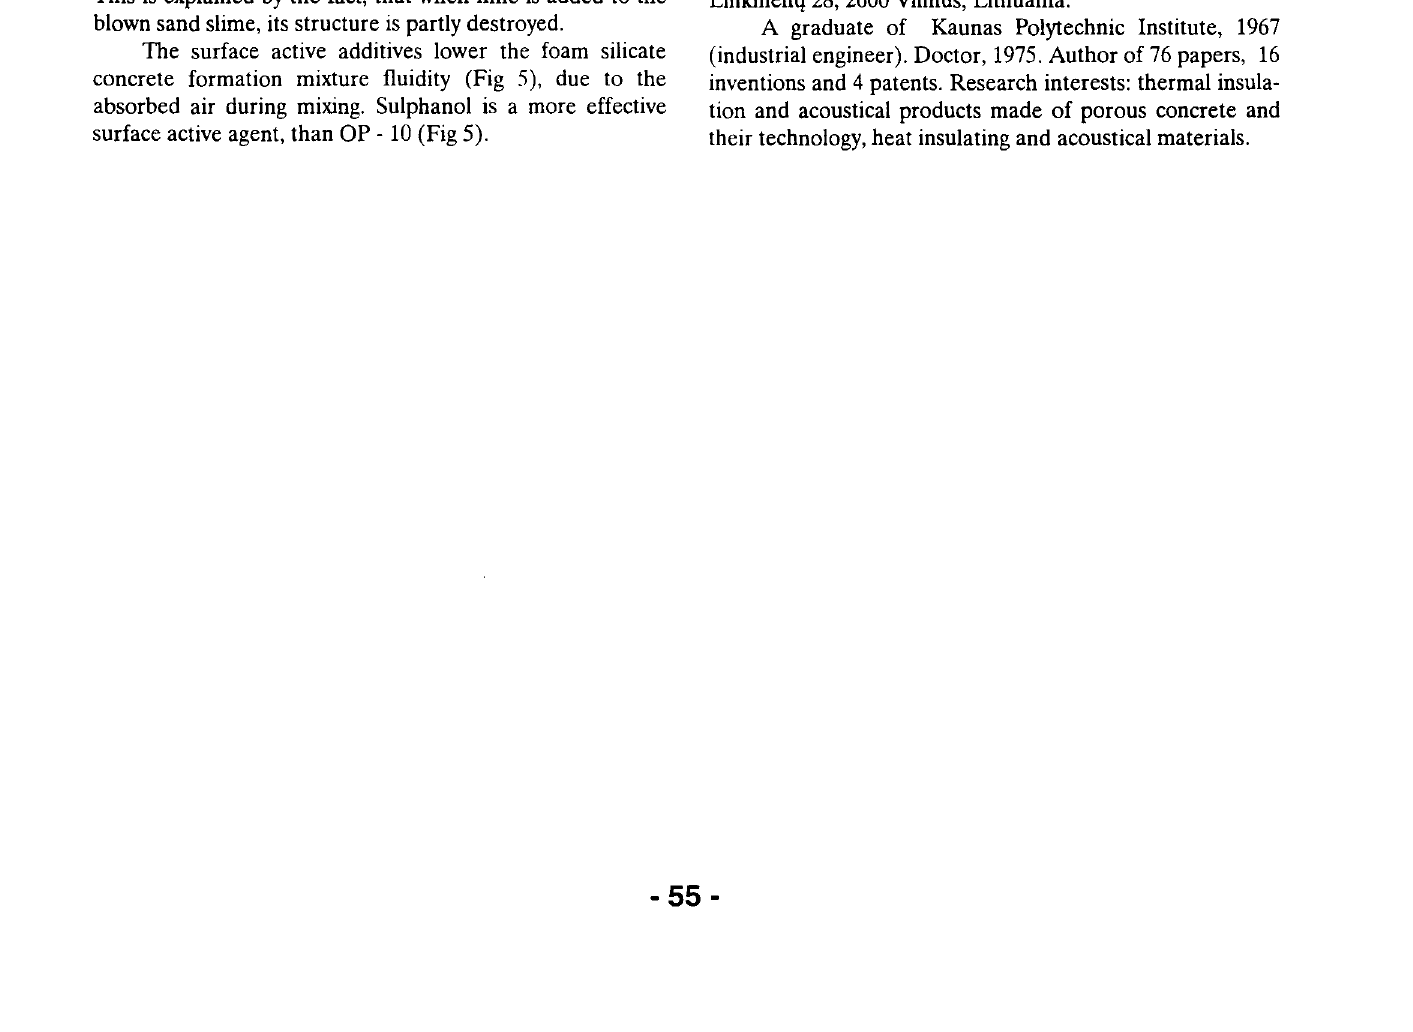
Table 1. Sand slime and porous silicate concrete mixture formation was performed in a laboratory mixer at 750